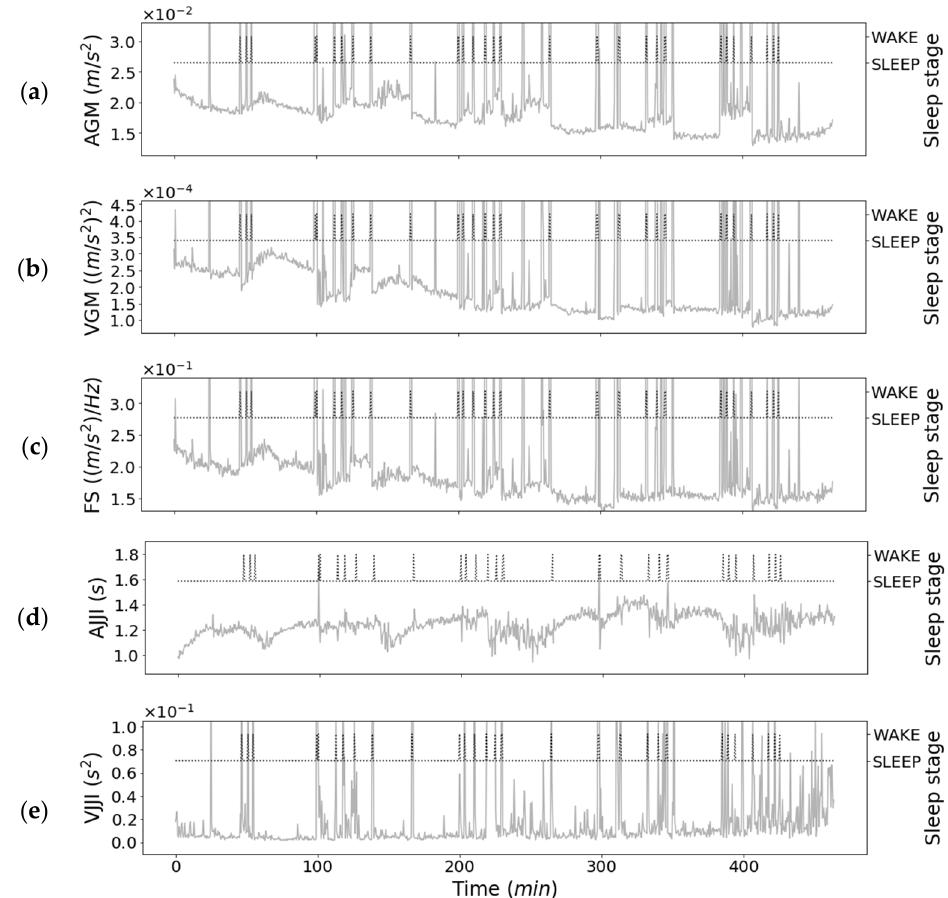
Figure 6. One subject’s results for overnight features with first-step classifier and sleep stage. (Subject: 1, Day: 2): ( a ) Average of gross movements; ( b ) Variance of gross movements; ( c ) Full spectrum; ( d ) Average of JJI; ( e ) Variance of JJI.